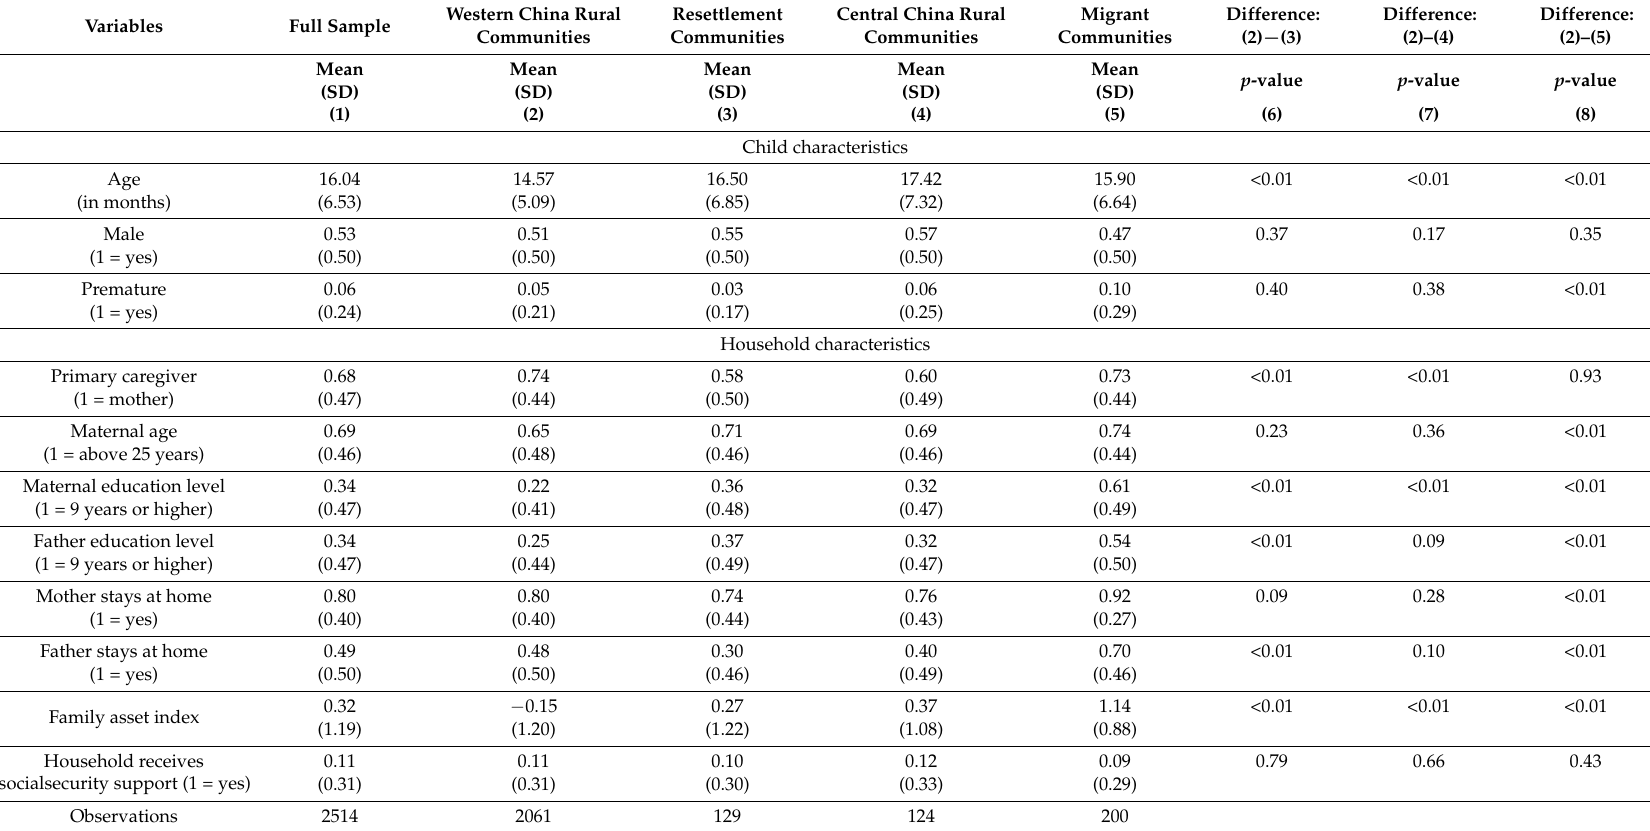
Table 2. Summary